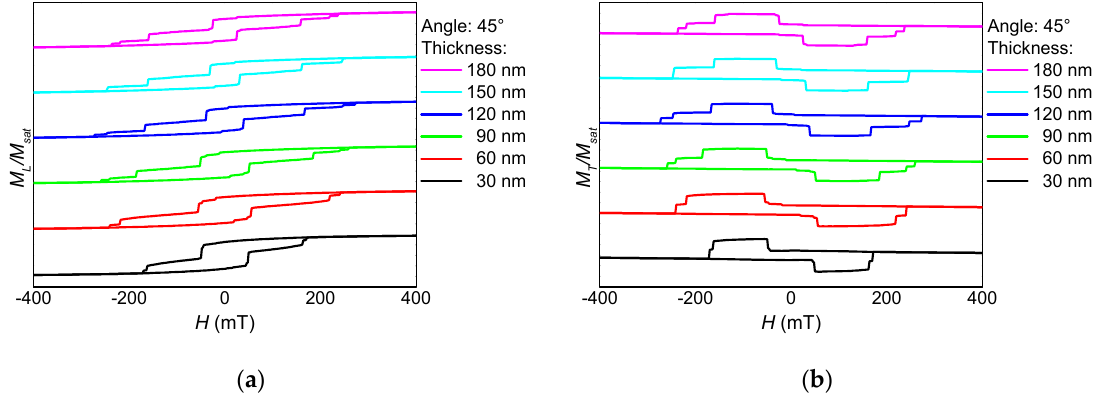
Figure 3. Thickness dependence of ( a ) the longitudinal and ( b ) the transverse hysteresis loops, simulated for sample NF1 under an angle of 45° (see Figure 1).